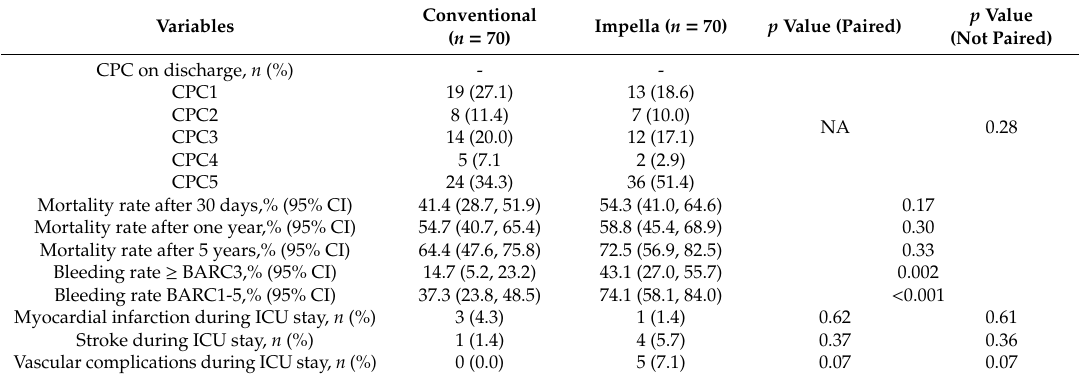
Figure 4. Neurologic outcome of patients treated without cardiocirculatory support versus patients treated Impella support. CPC scores at discharge of patients with no cardiocirculatory support (black) versus Impella support (red) ( p = 0.28) are displayed. Table 3. Clinical endpoints.